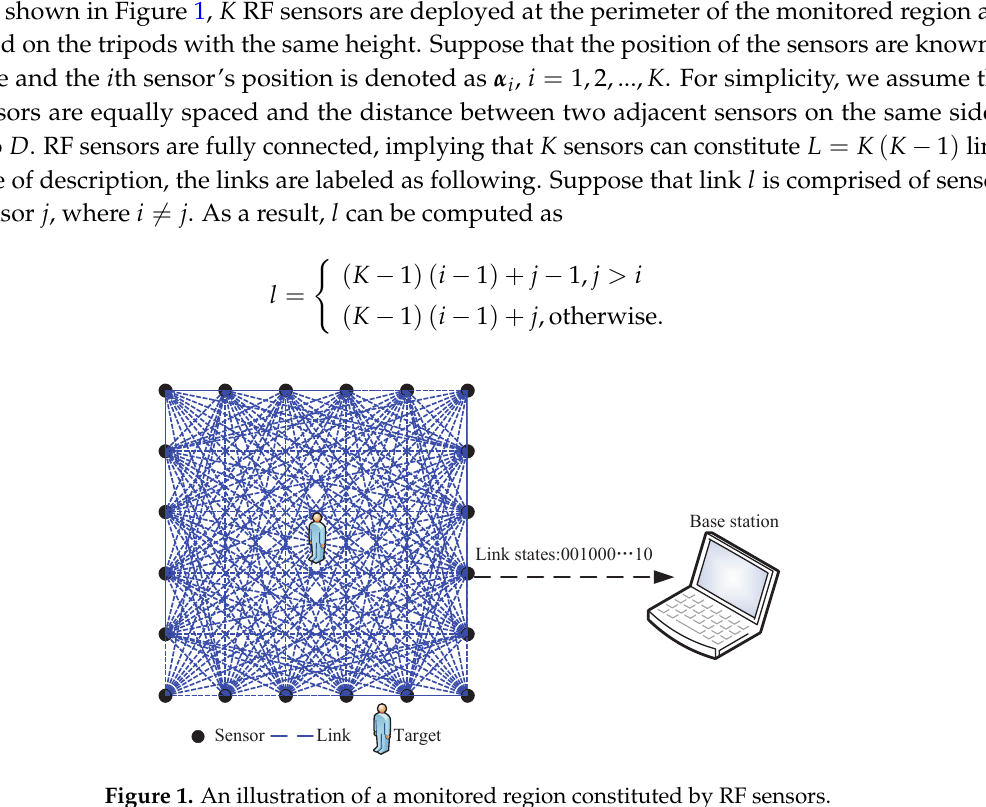
Figure 1. An illustration of a monitored region constituted by RF